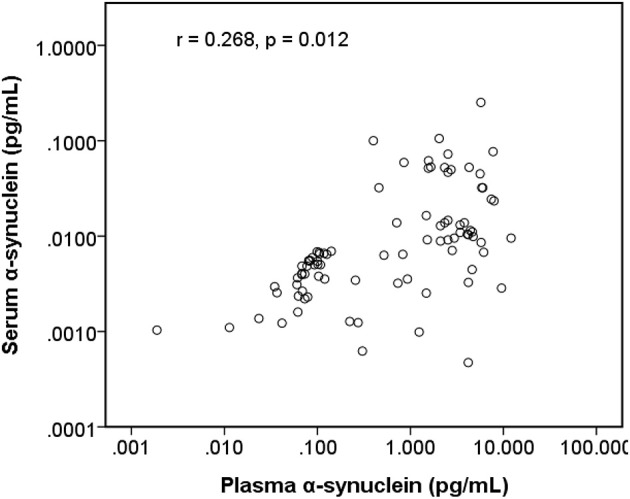
Scatter diagram between plasma α-synuclein levels and serum α-synuclein levels on a logarithmic scale.